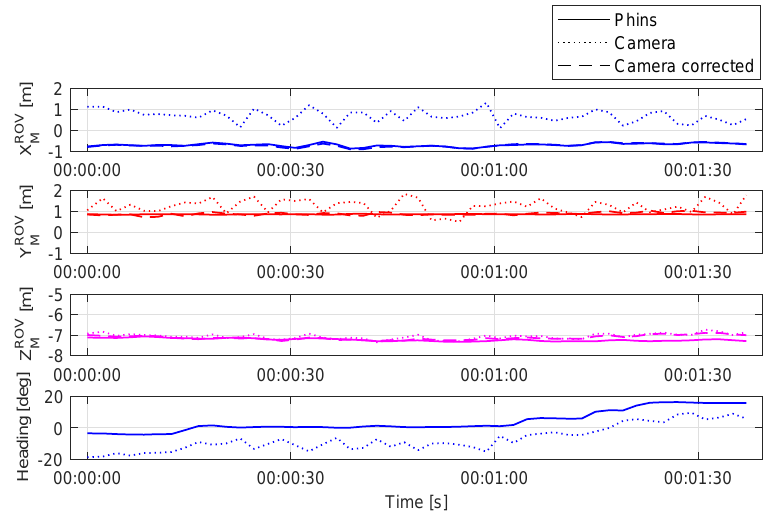
Figure 8. Position estimation of the camera in marker coordinate frame during the static test.